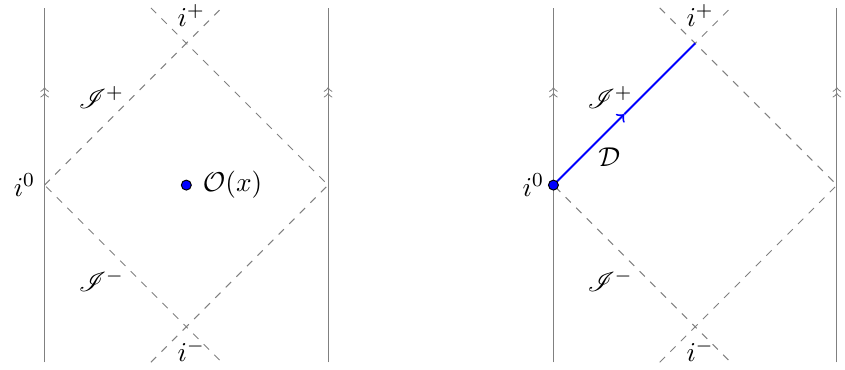
Figure 10. Illustrations of the traditional conformal frame (left), with a local operator O at a generic point inside Minkowski space, and the detector frame (right), where a detector D lies along future null infinity I + . The detector D transforms like a primary operator at spatial infinity i 0 (the blue point), which means that it is invariant under Minkowski translation generators, and this statement is exact in perturbation theory. In a CFT, future null infinity is not a special place, and can be reached by a simple shift on the Lorentzian cylinder. For simplicity of illustration, both figures show the 2d Lorentzian cylinder. For example, in the left figure, the two solid grey lines should be identified. Minkowski space is the interior of the diamond formed by dashed grey lines. The same is true for the figure on the